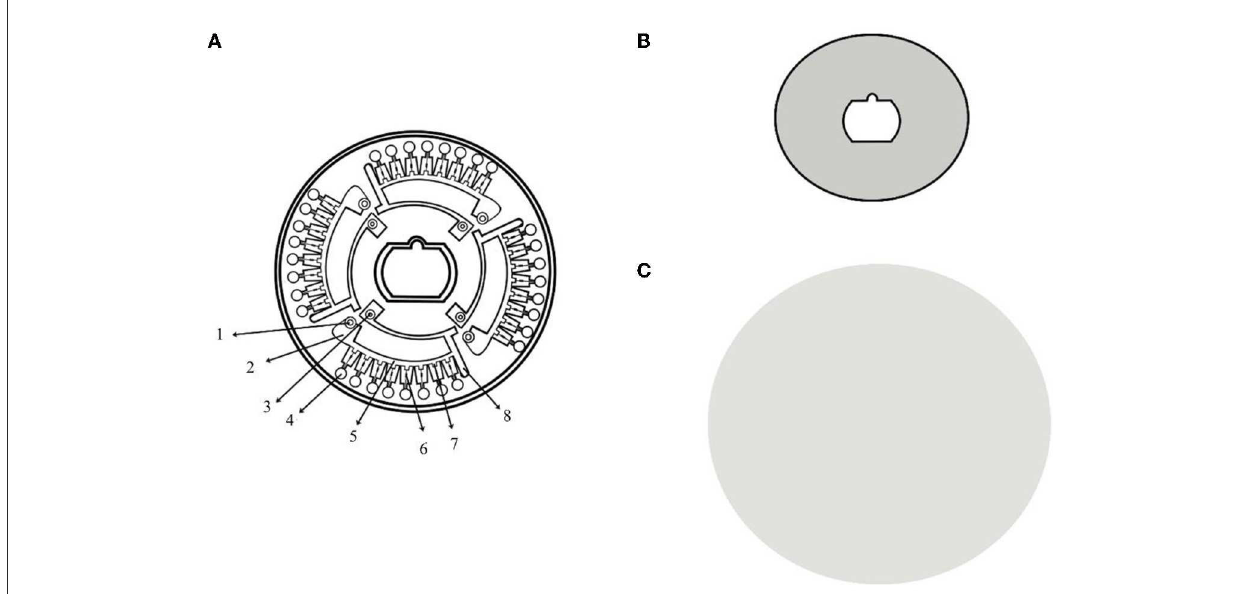
FIGURE1 Structure chart of microfluidic chip. (A) The structure of the CD-like microfluidic chip. 1: sample well; 2: liquid storage chamber; 3: vent hole; 4: reaction chamber; 5: the second arc passage; 6: ball valve; 7: reservoirs; and 8: waste liquid tank; (B) Heat-sealing film of the front side; (C) Heat-sealing film of the back